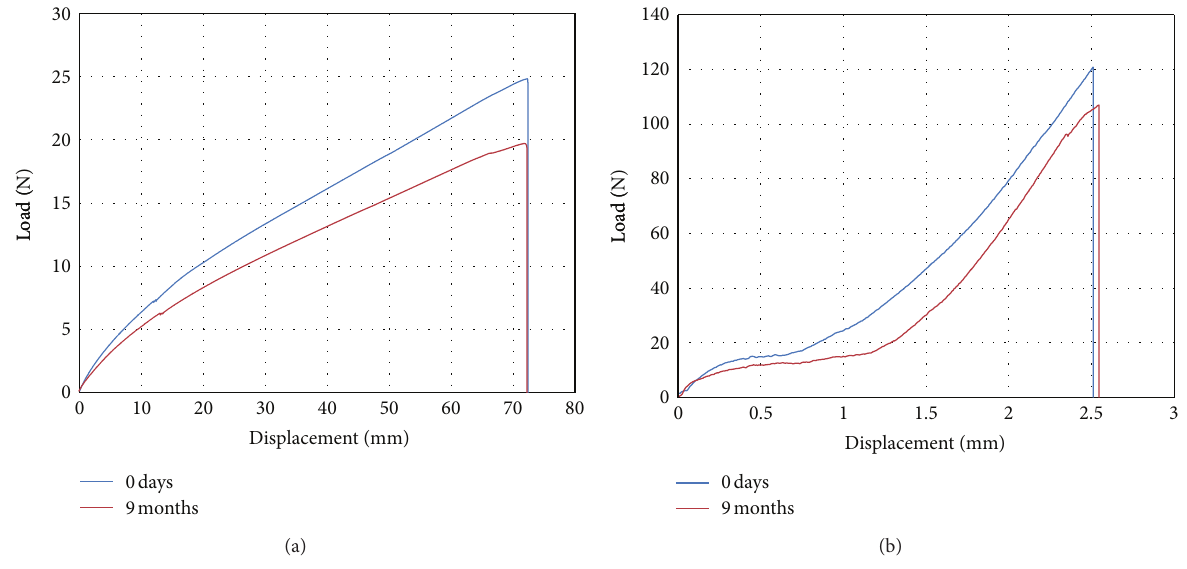
Figure 12: Tensile test load-displacement plots for (a) polyurethane and (b)